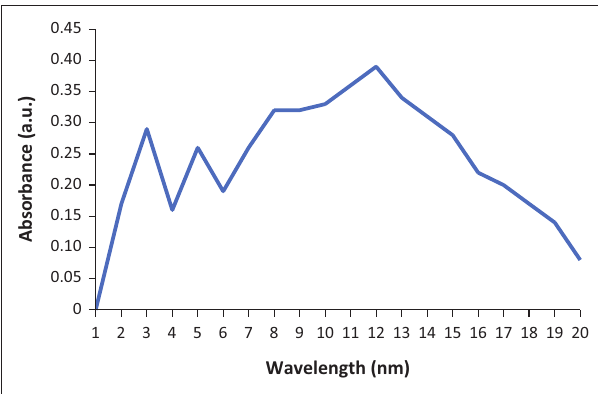
FIGURE 2: Ultaviolet–visible absorption spectra of silver nitrate with 1 mL Cannabis sativa leaf extracts 24 h after